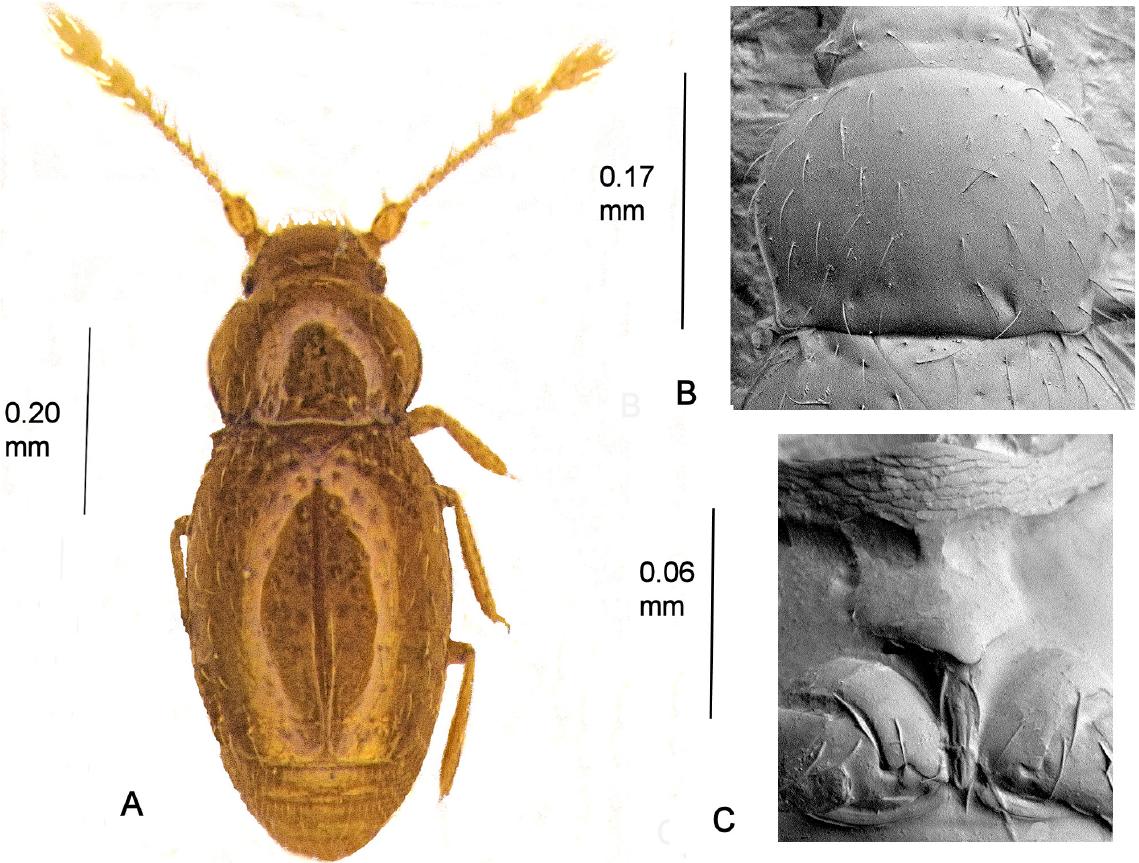
Fig. 23. Cissidium delicatum sp. nov. A . Habitus. B . Pronotum, × 695. C . Mesoventrite showing median process of collar, mid-keel and keel,